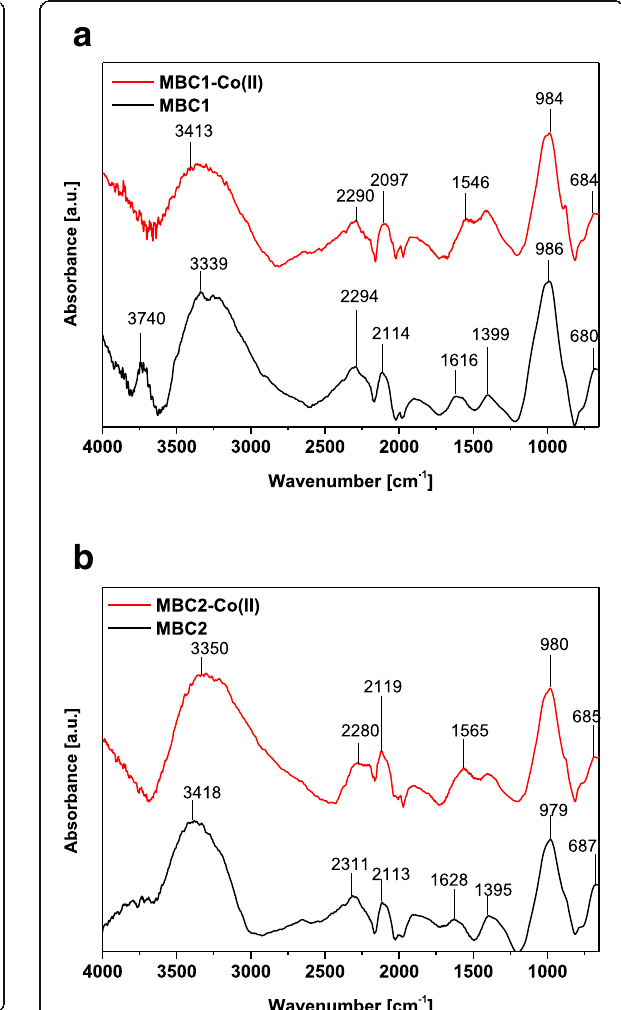
Fig. 5 FTIR spectra of a MBC1 and b MBC2 before and after the sorption of Co(II)